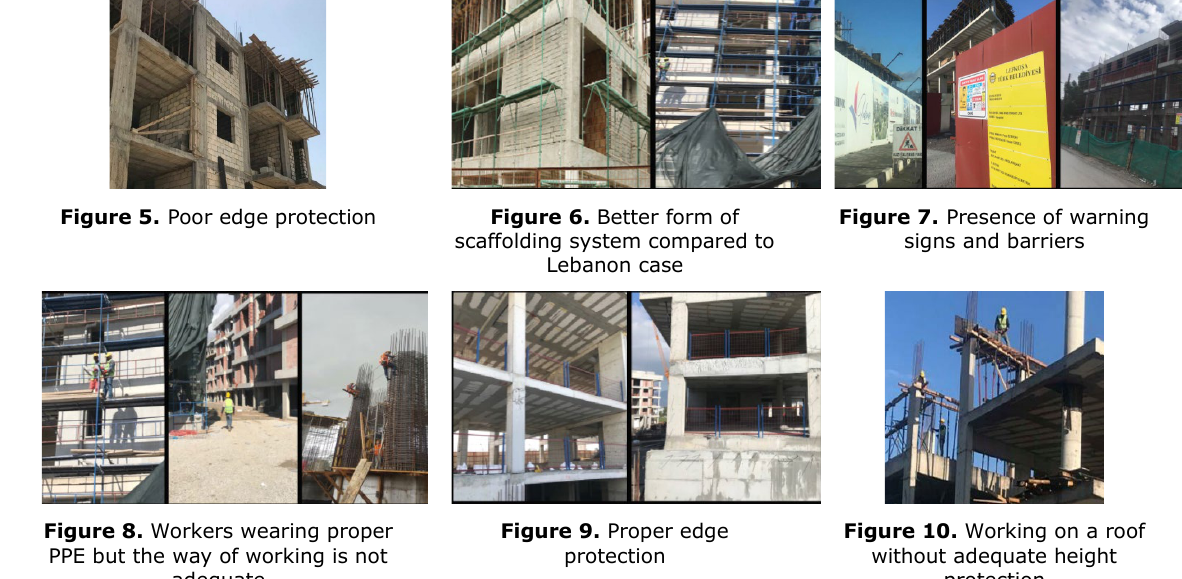
Figure 2. Workers undergoing construction activities without PPE